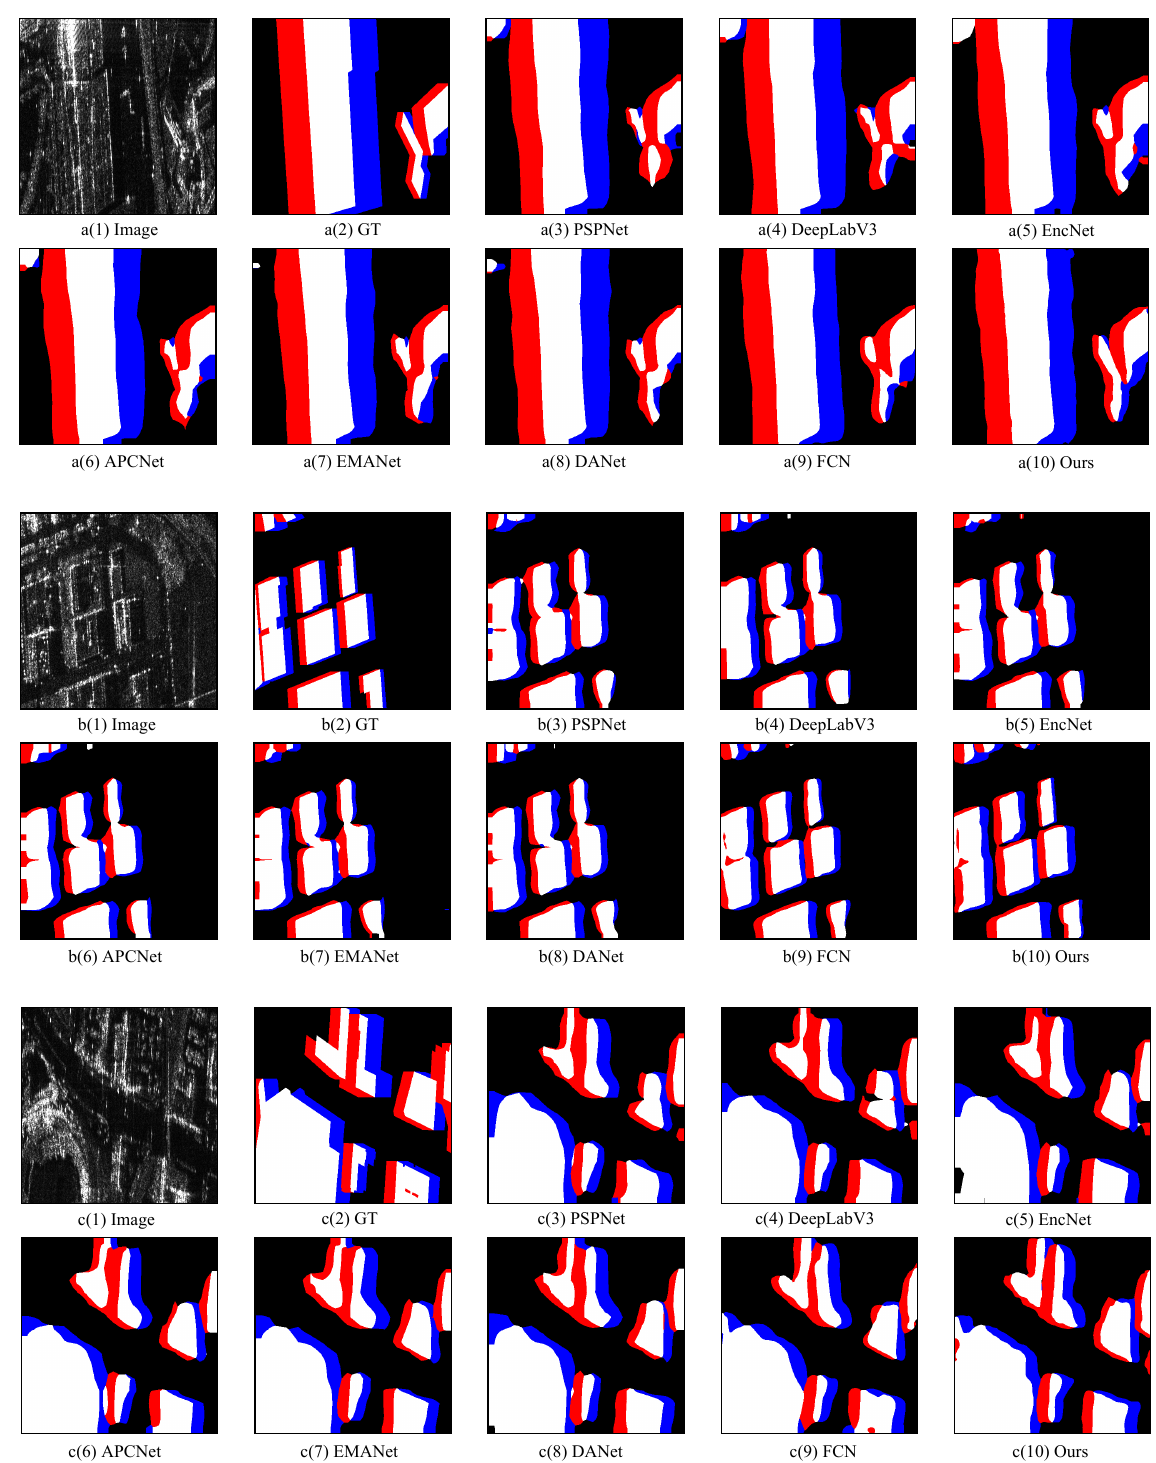
Figure 10. Inference results of the second set of